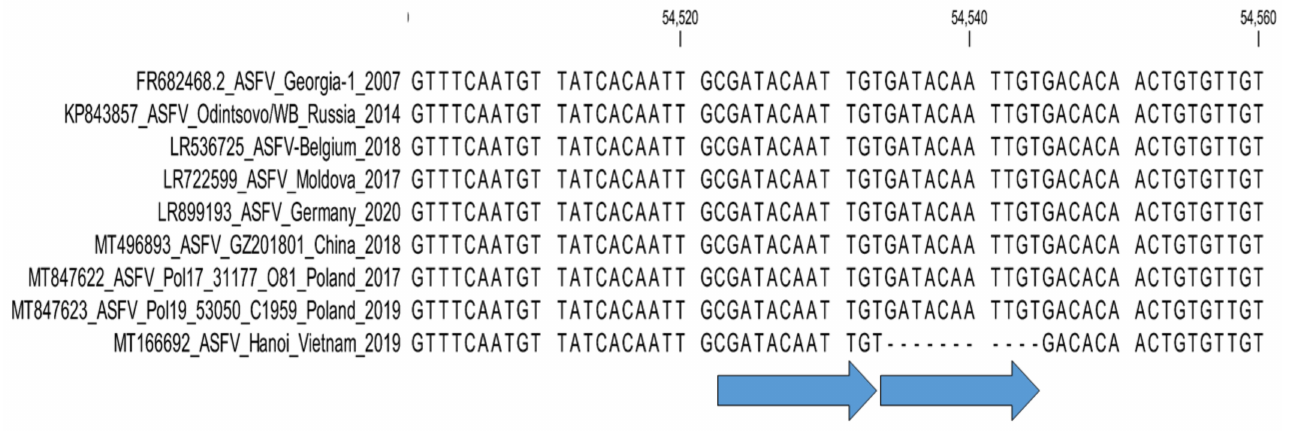
Figure 7. Nucleotide alignment of ASFV samples using the intragenic regions between ORFs A179L and A137R genes. Sample ASF_Hanoi_Vietnmam_2019 [MT166692] has only one copy of the 11 bp TRS sequence, compared with the two copies in Georgia 2007/1.